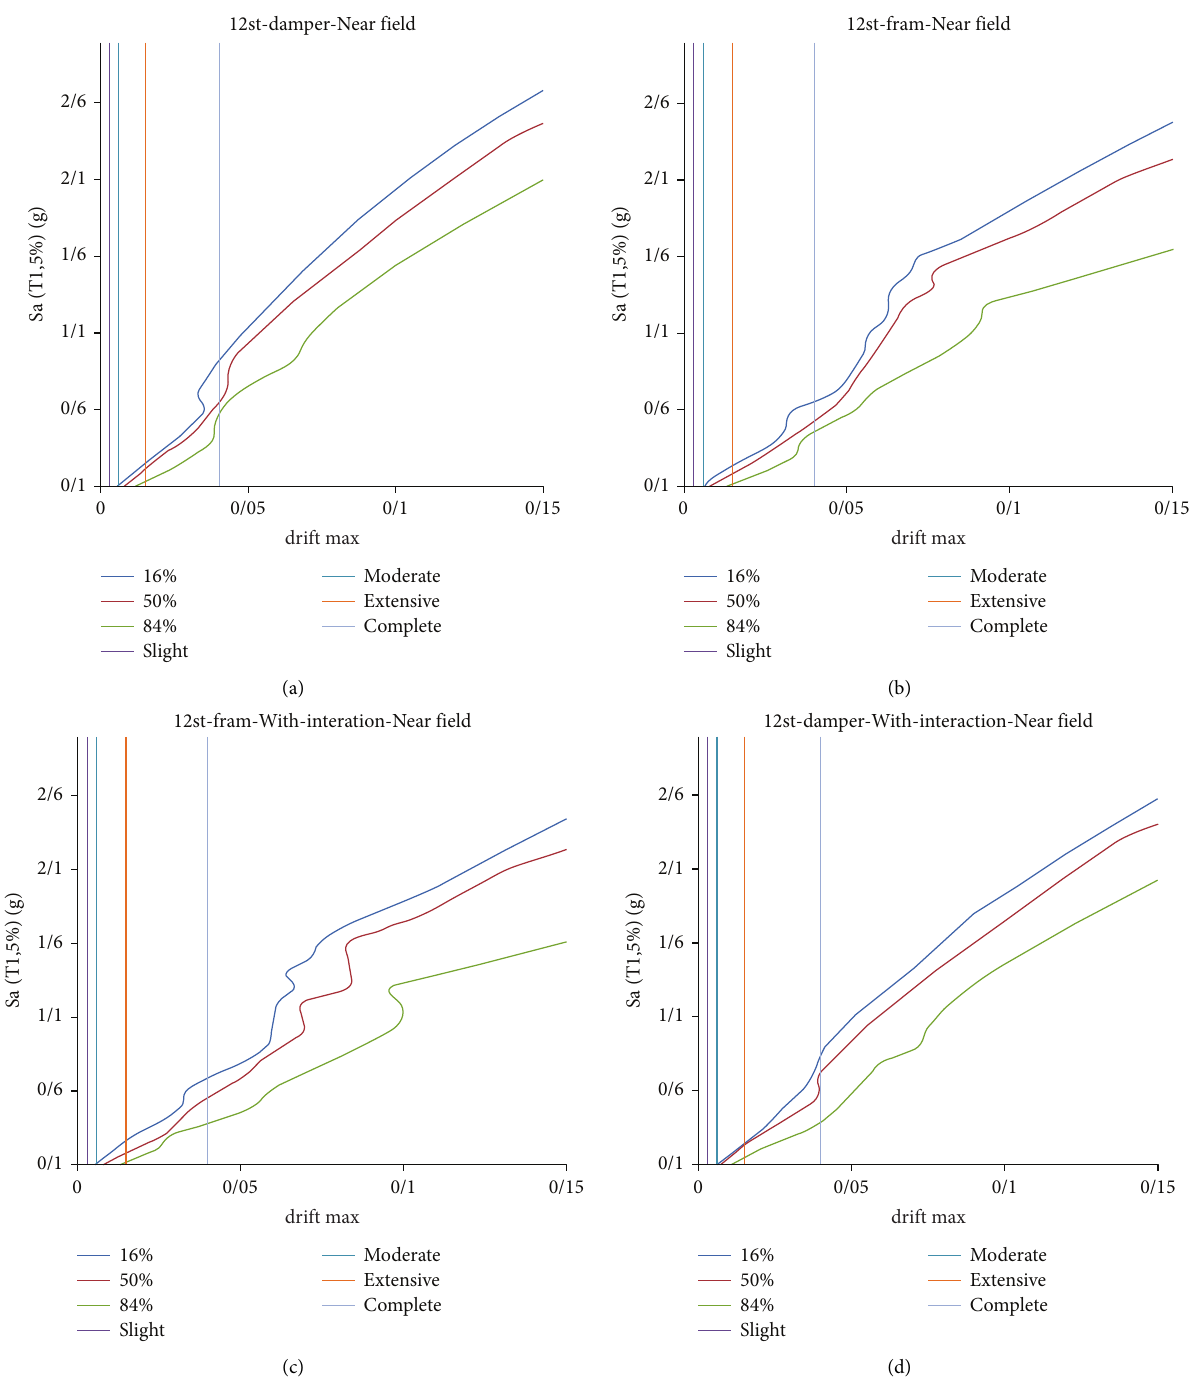
Figure 13: Summary of IDA curves for 16%, 50%, and 84% percentiles in 12-story ordinary moment resisting frame affected by near-field earthquakes. Examined cases: (a) with damper without considering SSI; (b) without damper and SSI effect; (c) with damper and considering SSI; (d) without damper but considering SSI